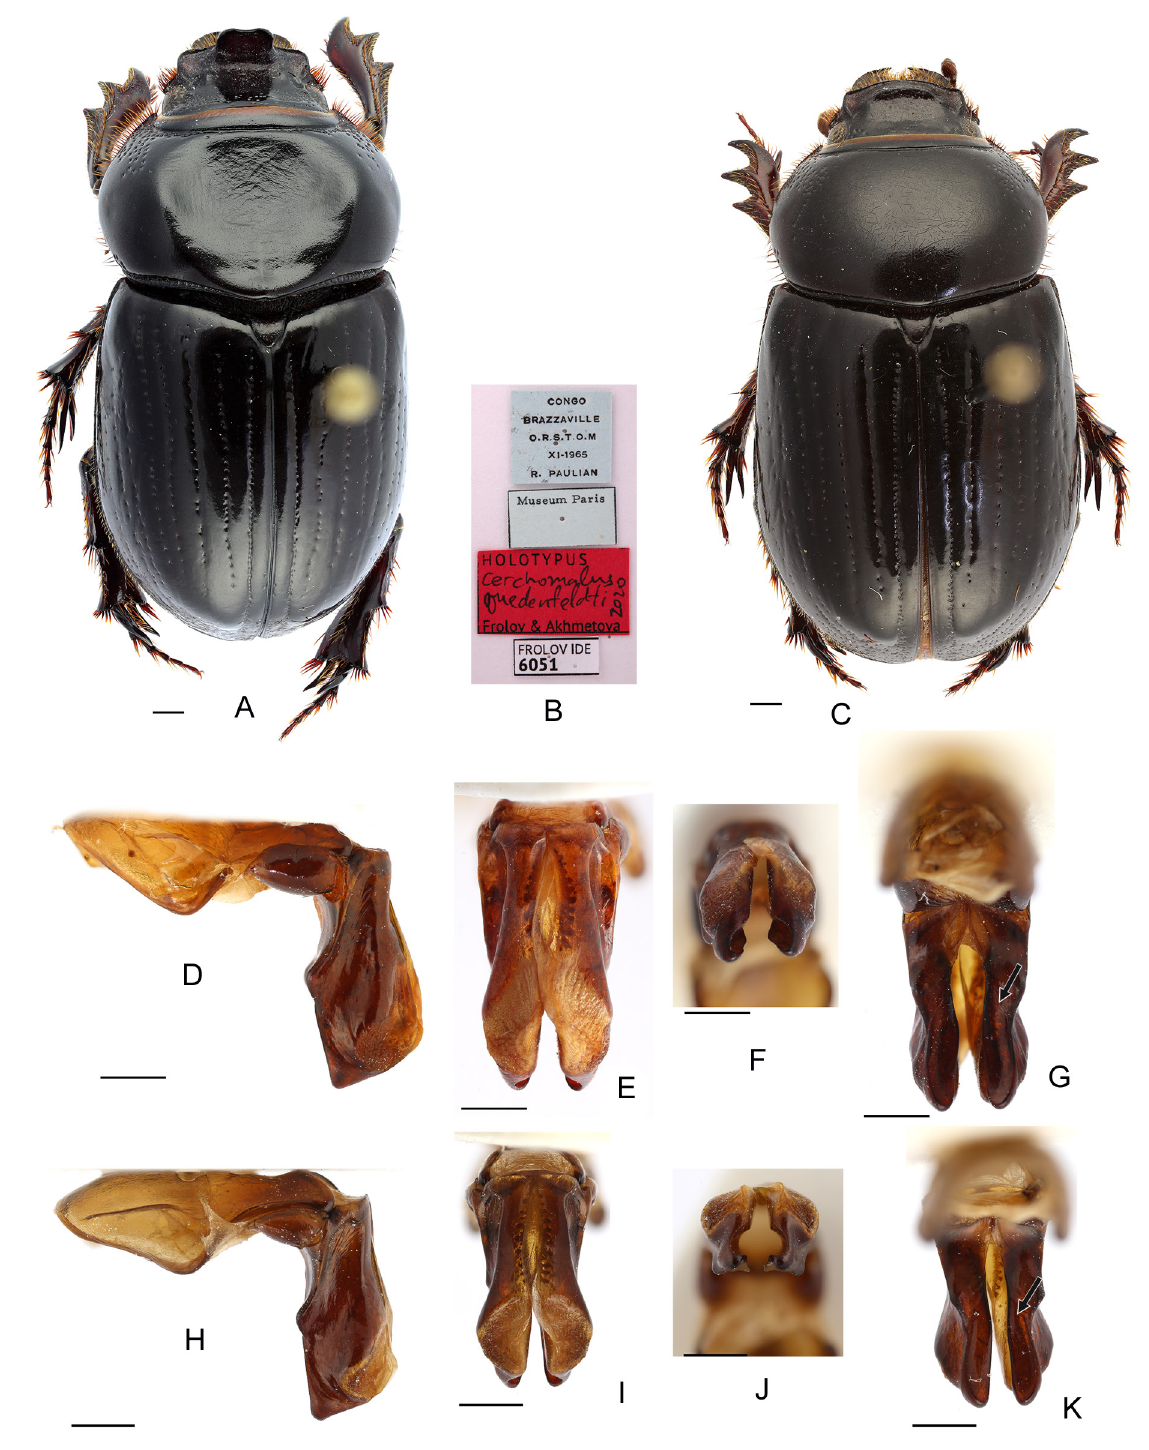
Fig. 4. Cerhomalus quedenfeldti sp. nov. A–B, D–G . Holotype, ♂ (MNHN). C . Paratype, ♀ (MNHN ). H–K . Paratype, ♂ from Voka ♀ (MNHN). A, C . Habitus in dorsal view. B . Labels. D, H . Aedeagus in lateral view. E, I . Parameres in dorsal view. F, J . Parameres in apical view. G, K . Parameres in ventral view. Scale bars = 1.0